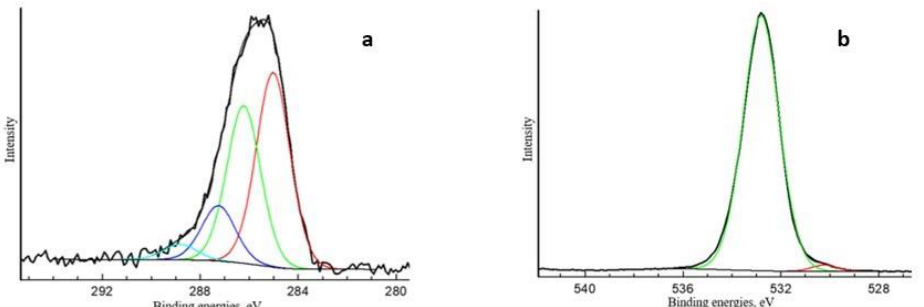
Figure A2. C1s ( a ) and O1s ( b ) XPS spectrum of the test sample.